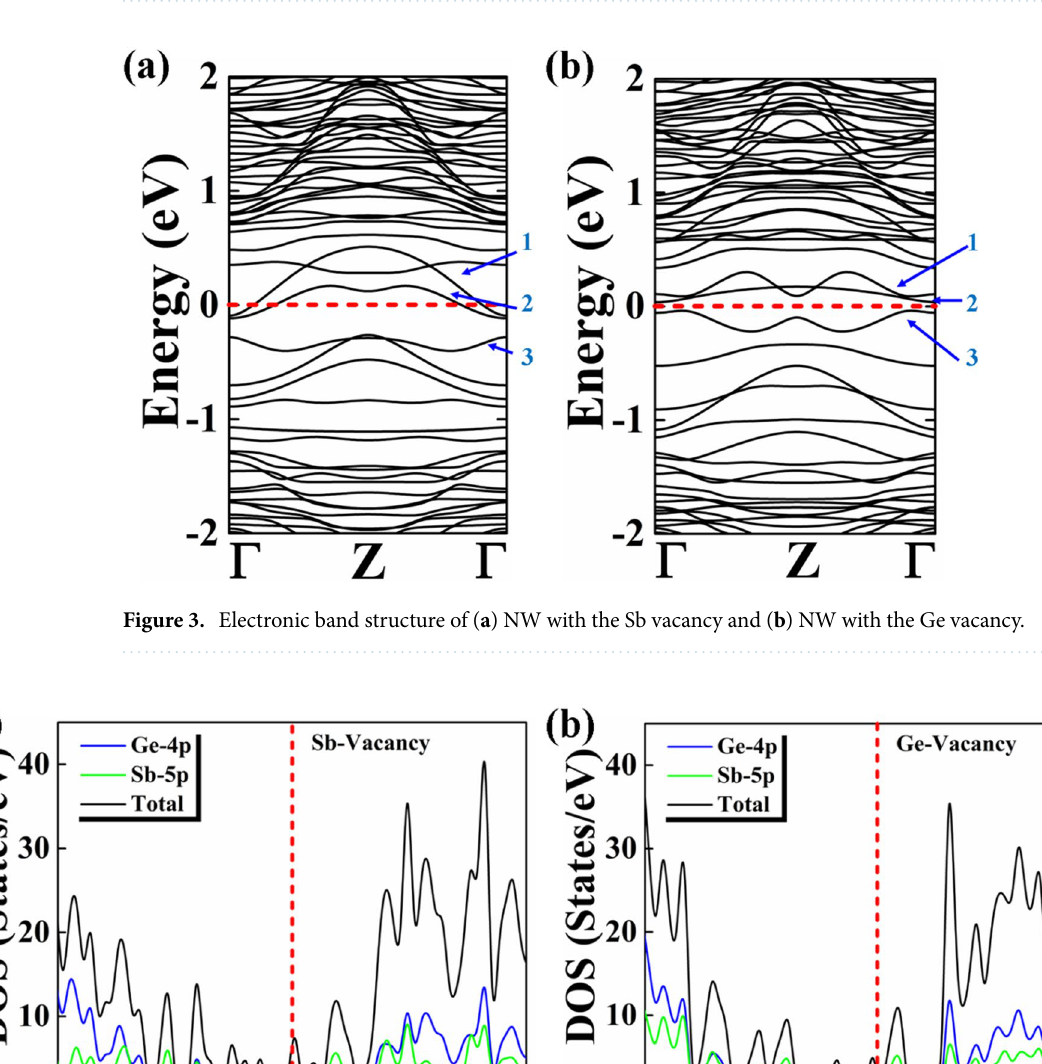
Figure 2. ( a ) (1 × 1 × 3) supercell of pristine Sb/Ge NWs where the red circles indicate the sites of the Ge and Sb vacancies ( b ) optimized structure of the Sb/Ge NWs with Sb vacancy and ( c ) optimized structure of the Sb/Ge NWs with Ge vacancy.